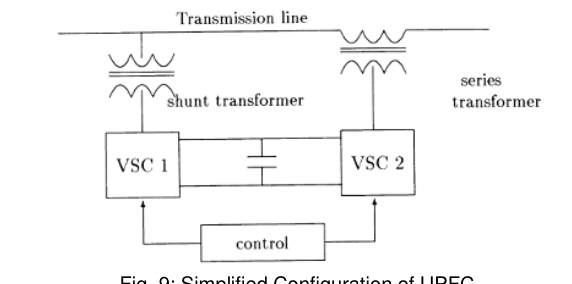
Fig. 9: Simplified Configuration of UPFC